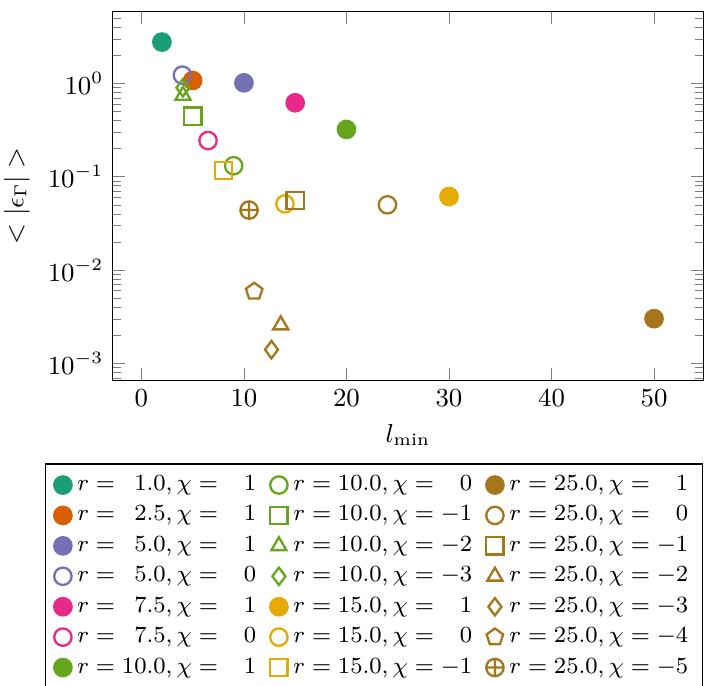
Figure 13. Average absolute relative error < | (cid:101) Γ | > as a function of the minimal characteristic length scale of the system, l min . In the case of a pore without rods, this distance is twice the radius. When rods are present within the pore this is the smallest distance between the pore wall and a rod or between two different rods. Because the excess adsorption is a derivative of the grand potential, the observed error is larger than Figure